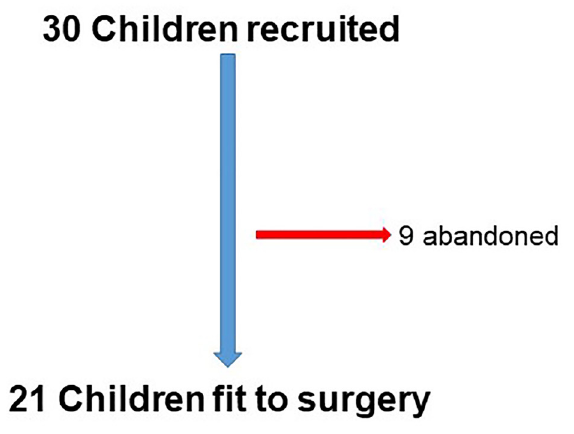
Figure 3 - Patient recruitment flowchart.